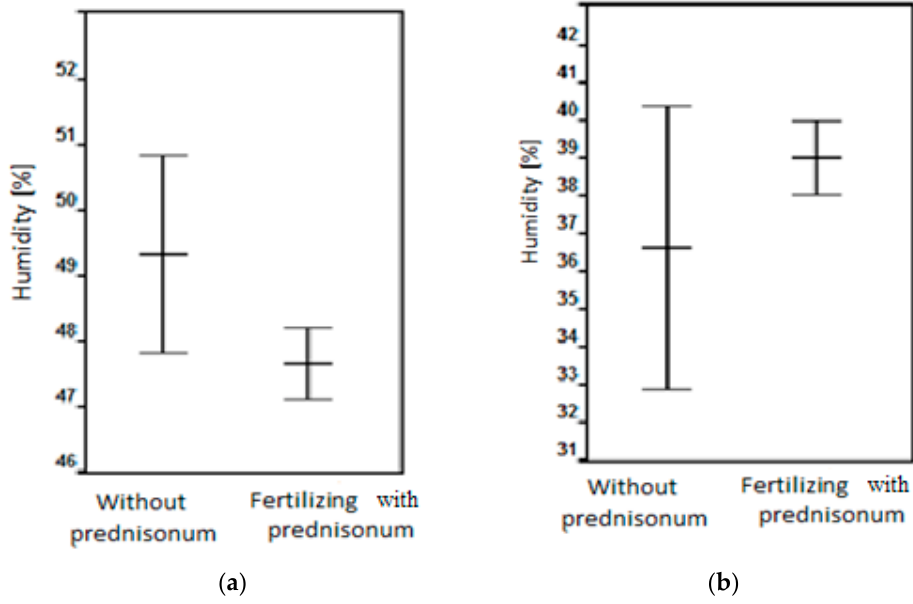
Figure 8. Significance of the effect of prednisonum fertilization on the parameters; ( a ) energetic willow moisture, ( b ) soil moisture